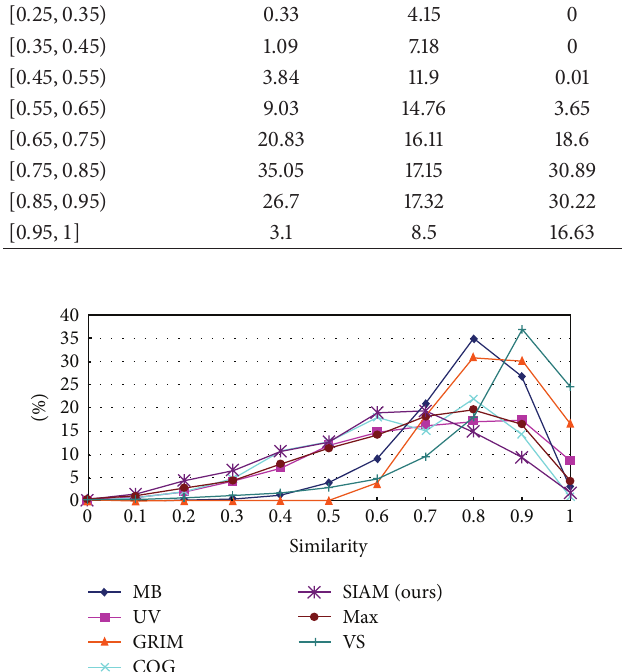
Figure 3: Similarity distribution of the different